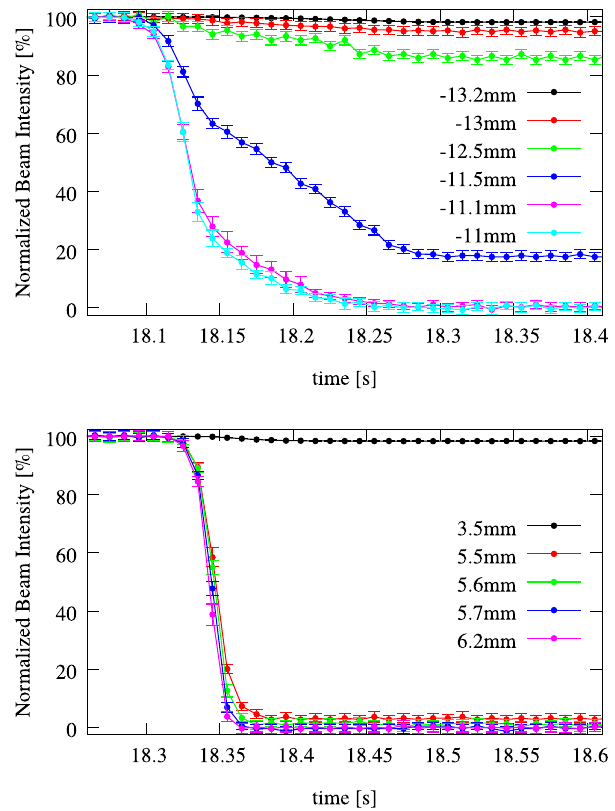
FIG. 4. Normalized BCT signals at low beam intensity obtained during the scraper scans with the horizontal (upper frame) and vertical (lower frame) blades. The shown curves are the average over consecutive fills at the same target position. When visible, error bars refer to the maximum between the dispersion of the sets of data used to compute the averages and the error propagation. It should be noted that the positions in the legend refer to the calibration of the blade mechanics, not to the closed orbit.